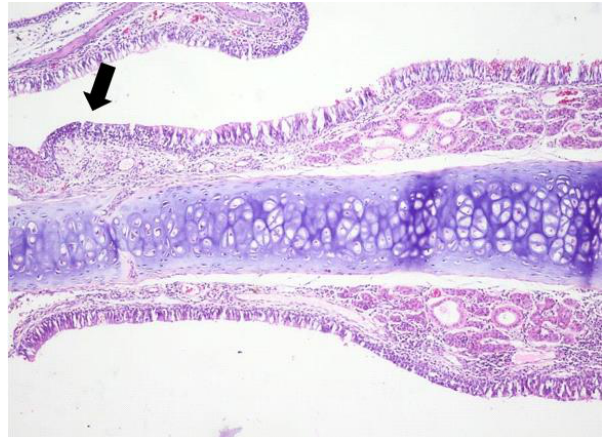
Figure 1. Light micrographs of the rat’s nasal septum, control group, at 5 days after the intranasal intervention. Bilateral, minimal, diffuse infiltration of the lamina propria of the mucosa covering the nasal septum by few mononuclear cells. Focally, the lamina propria is expanded by fibrous connective tissue and the covering mucosa is infiltrated by lymphocytes, macrophages and plasma cells (arrow); H&E, ob ×10.